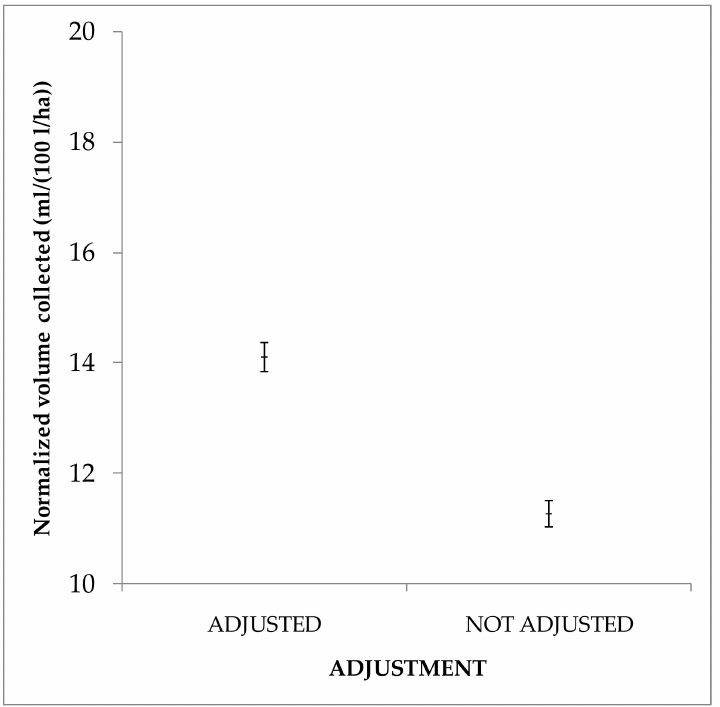
Figure 17. Adjustment effect on the normalized volume collected in the canopy zone (mean ± SE) with the C1